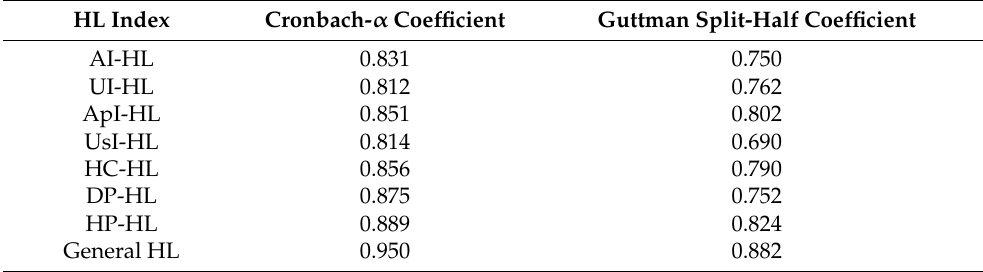
Table 1. Cronbach- α and Guttman split-half coefficients for HL indices used in the